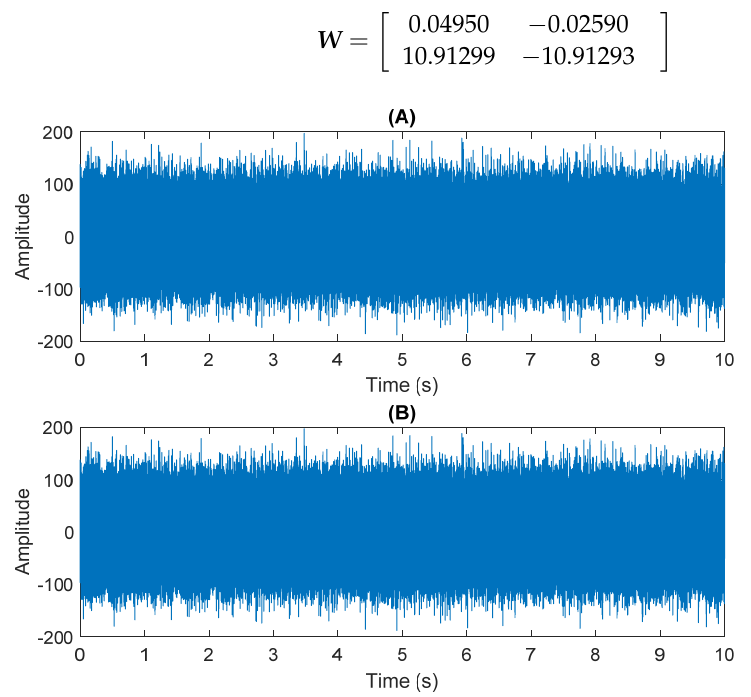
Figure 21. The numerical simulation of data received by two sensors: ( A ) In Equation (31) the sensor signal x1. ( B ) In Equation (31) the sensor signal x2.